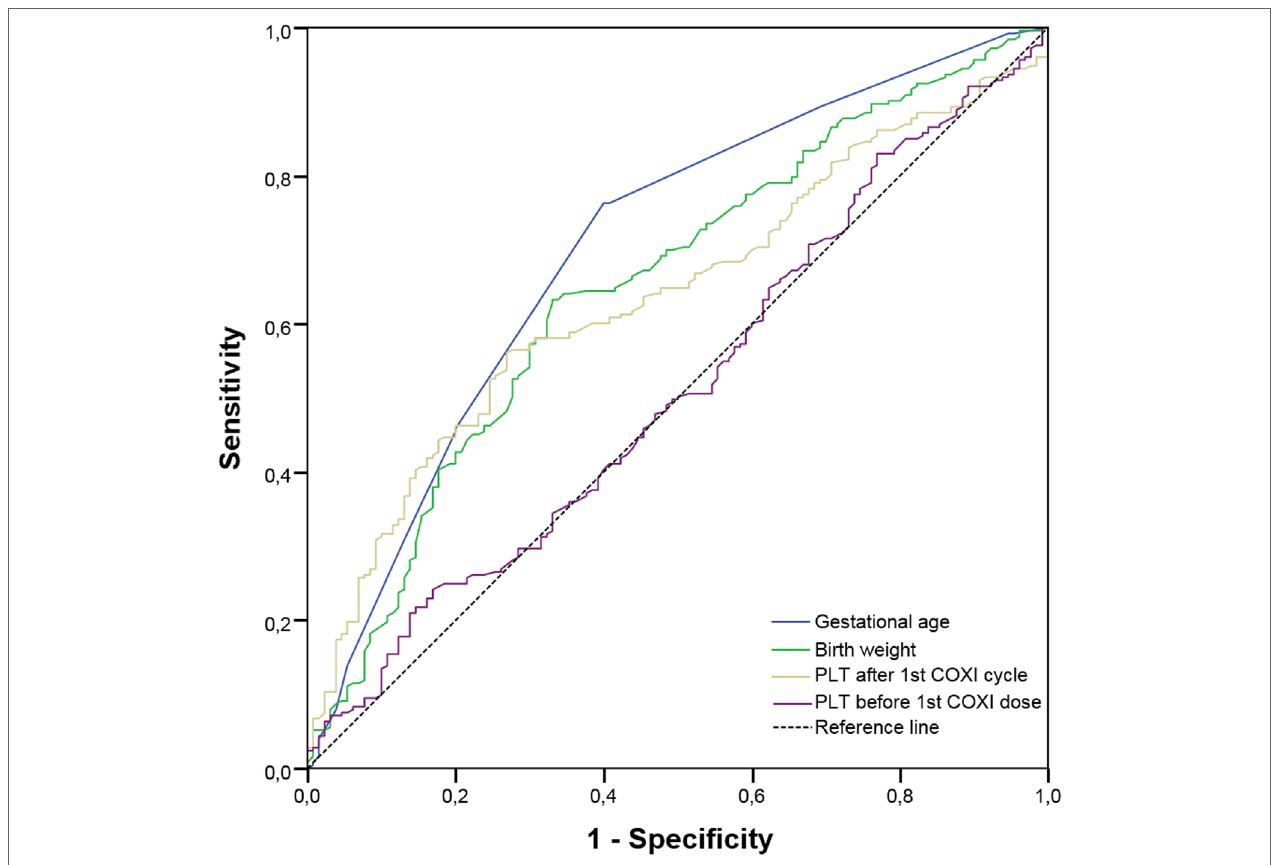
FigUre 2 | Receiver operating characteristic (ROC) curve analysis. The ROC curve analysis shows a significant association between platelet counts after the first cyclooxygenase inhibitor (COXI) cycle and treatment failure with an area under the curve (AUC) of 0.617 and a confidence interval (CI) of 0.560–0.674. However, the form of the curve indicated no specific cutoff that could be used to predict treatment failure below a specific platelet count. Of note, similar results were obtained for platelet counts before and after the second COXI cycle (data not shown). For comparison, we also included platelet counts before the first COXI dose (AUC